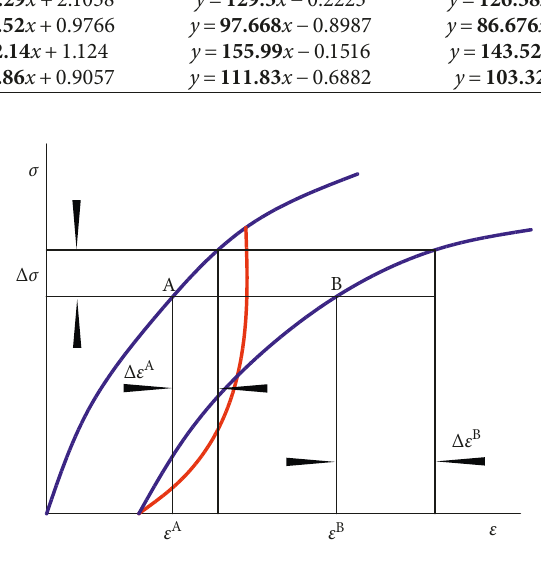
Figure 10: Influence of the stress history on